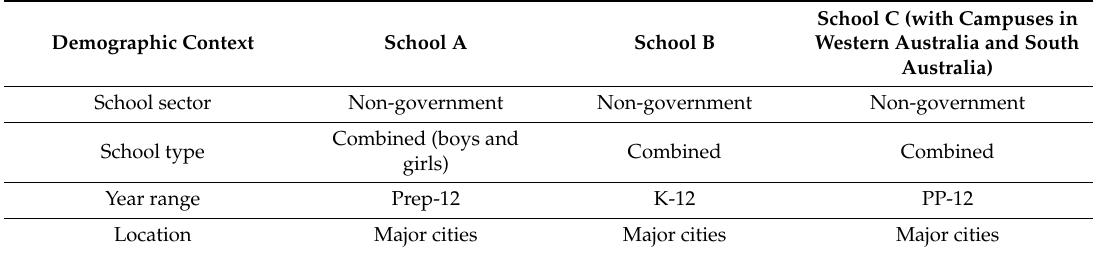
Table 1. Context overview (2019). Source: https: // www.myschool.edu.au /